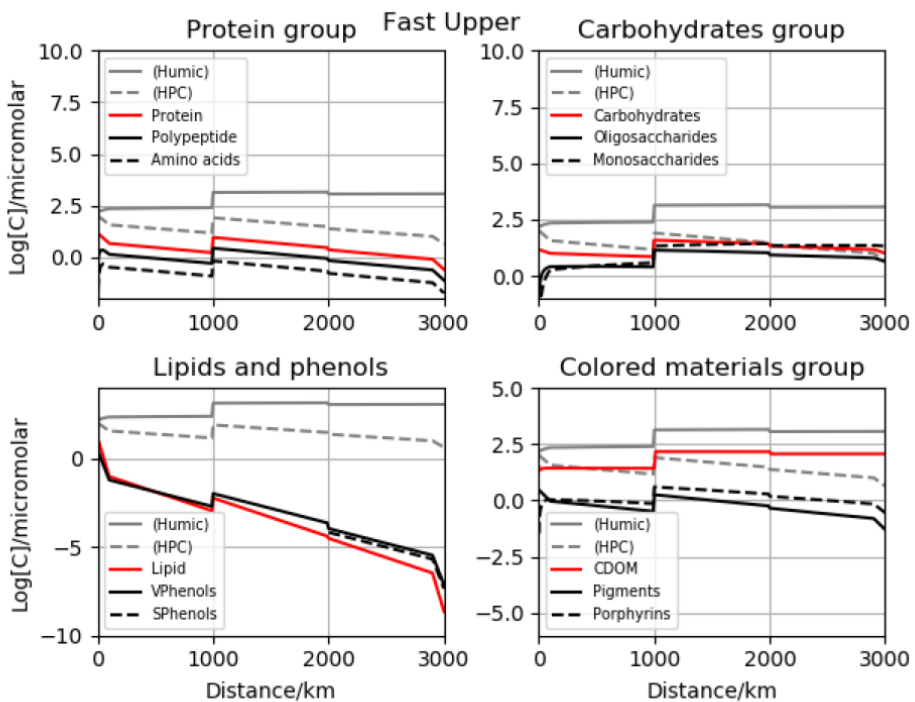
Figure 4. Results from the fast upper-concentration scenario—example of a less successful counterpart to the recommended slow low simulation. Final values fall well below measurement indicators of Table 3 in several instances. Note that the range of a given log scale is tailored to its individual panel.